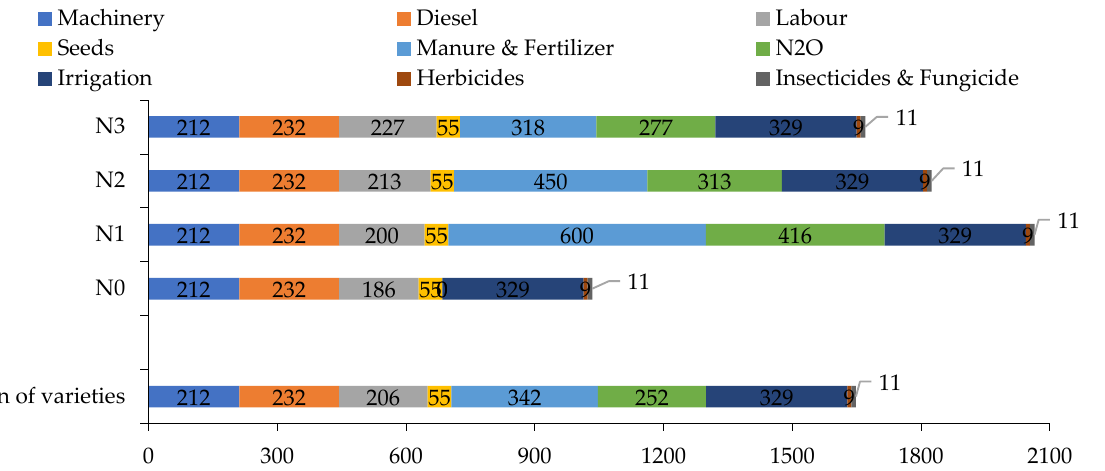
Figure 7. Source-wise equivalent carbon emission (kg CO 2 -e ha − 1 ) for fodder maize varieties sown under different nutrient management practices (mean of two years).